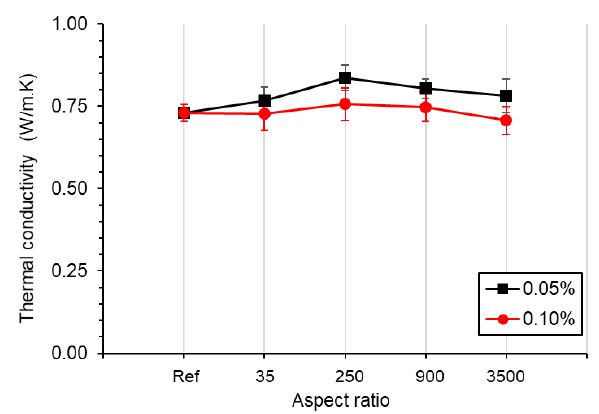
Figure 6. Thermal conductivity of the pastes as a function of CNT aspect ratio and